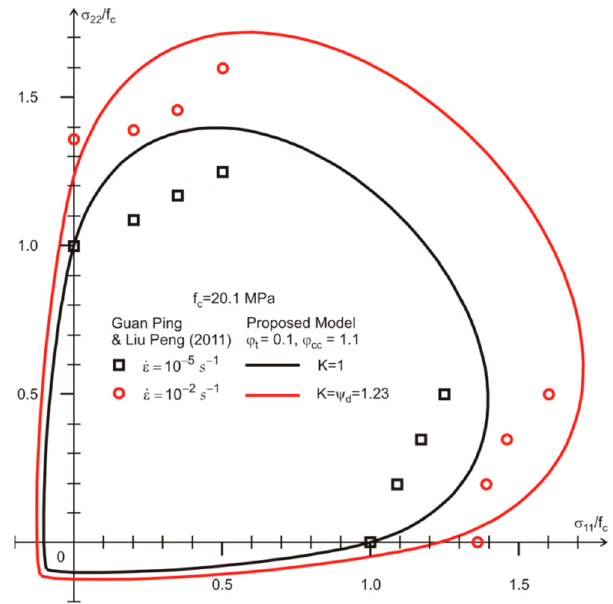
Figure 10. Comparison of the proposed dynamic strength criterion with experimental results by Ping and Peng [50] for biaxial compressive–compressive loading tests.